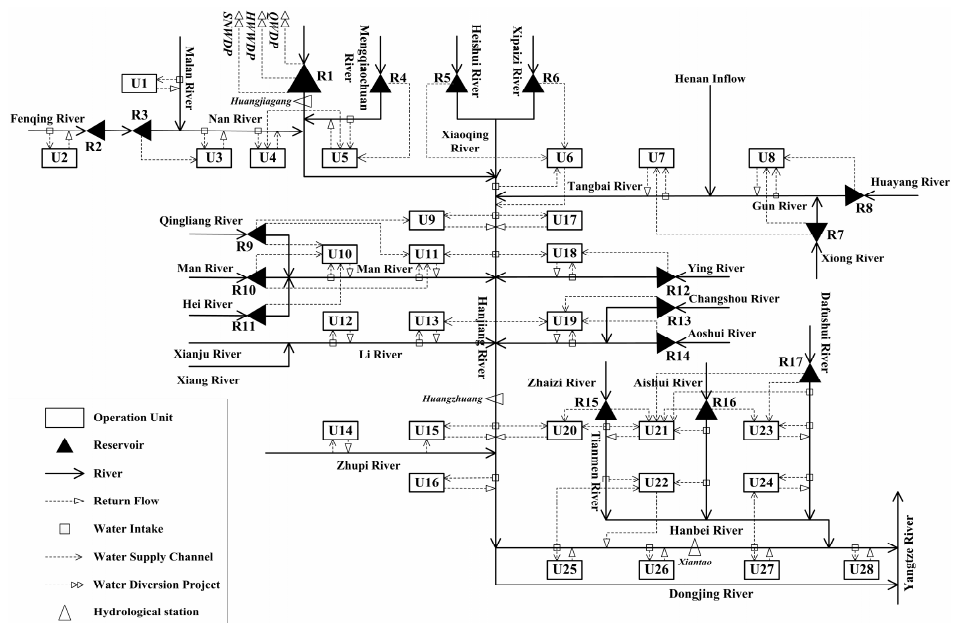
Figure 2. The water network of the mid ‐ lower reach of Hanjiang River basin (MLHRB).